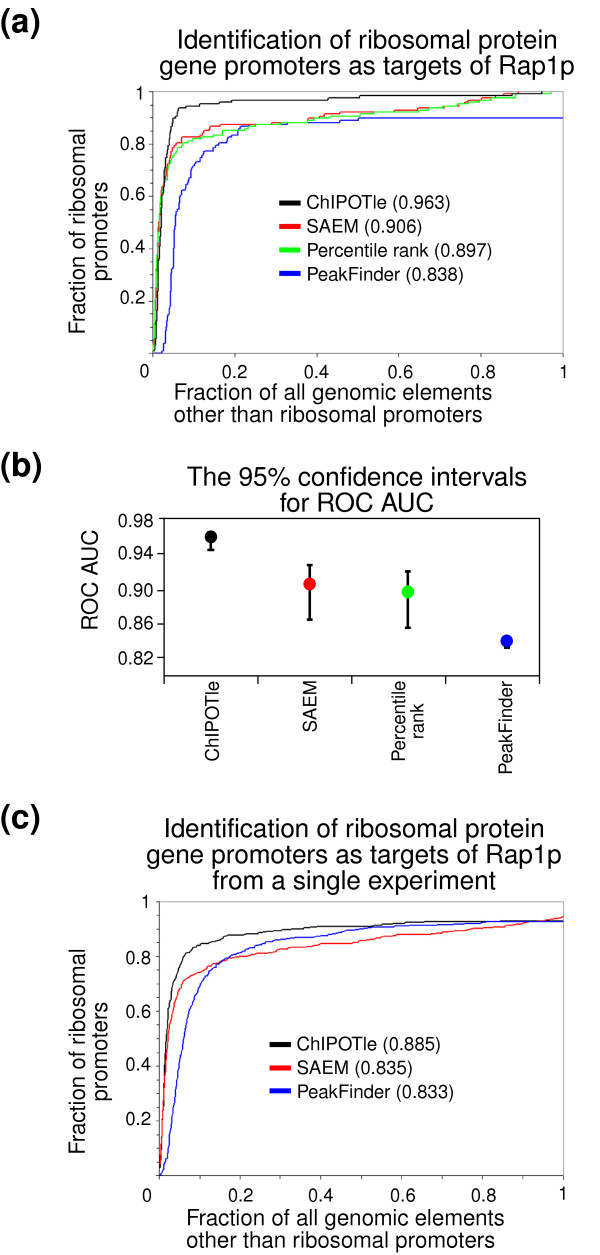
Comparison of ChIPOTle with other ChIP-chip analysis approaches. (a) ChIPOTle, the single-array error model (SAEM), median percentile rank, and PeakFinder were used to analyze the same four Rap1p ChIP-chip replicates reported by Lieb and coworkers [13], and judged by their ability to determine enrichment of ribosomal protein gene (RPG) promoters. The binding site for Rap1p is found in most (>90%) RPG promoters [14], which represent approximately half of Rap1p's total in vivo targets. Receiver operating characteristic (ROC) curves summarize the power of each technique and are equivalent to a plot of the true-positive rate (fraction of ribosomal promoters) versus the false-positive rate (fraction of all genomic elements other than ribosomal promoters). Each technique is judged by means of the area under the ROC curve (AUC). An AUC value of 0.5, corresponding to a diagonal ROC curve, is expected by chance, whereas a value of 1.0 indicates a technique that predicts targets perfectly. ChIPOTle (AUC = 0.963) outperformed the other techniques tested here (SAEM: AUC = 0.906; median percentile rank: AUC = 0.897; and PeakFinder: AUC = 0.823). When comparing ChIPOTle with PeakFinder, we used the default settings for smoothing (n = 5 [11-point] smoothing with 7 rounds). In addition, we attempted to optimize the settings by trying varying levels of smoothing, including 7-point and 13-point, which produced similar results. Rap1p's strongest binding sites are located at the telomeres, which are not included with our defined 'true positive' set of RPG promoters. Therefore, the false-positive rate will be somewhat inflated, which will decrease the AUC for all techniques. This is reflected in the ROC curves by the low true-positive rate at the extreme left of the plot. (b) The 95% confidence interval for the AUC for each analysis technique was estimated by bootstrap resampling of RPG occurrence and enrichment value (1,000 iterations) as measured in each technique (P value, percentile rank, or ySmooth). Boostrapping of raw data was not practical because of inability to automate all four analysis methods. (c) ROC curves comparing ChIPOTle, SAEM, and PeakFinder with respect to their ability to identify enrichment of RPG promoters from a single experiment. The average true-positive rate (fraction of ribosomal promoters) versus false-positive rate (fraction of all genomic elements other than ribosomal promoters) for the four individual experiments is plotted. The three techniques performed extremely well, but ChIPOTle (AUC = 0.885) outperformed both SAEM (AUC = 0.835) and PeakFinder (AUC = 0.833).